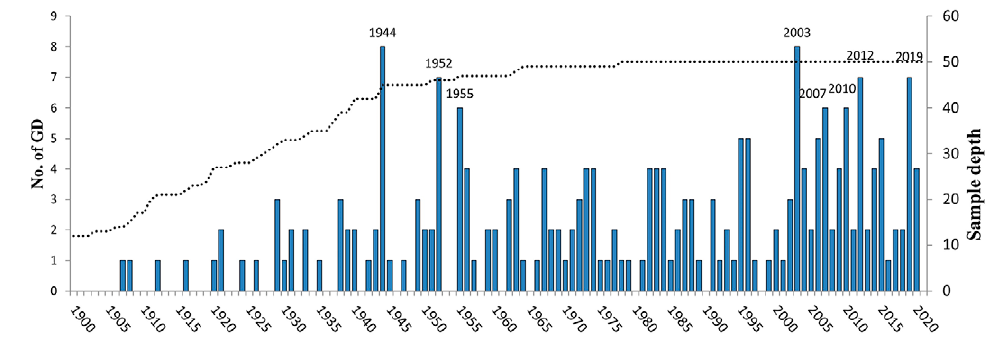
Figure 8. Histogram showing the total number of growth disturbances per year at site